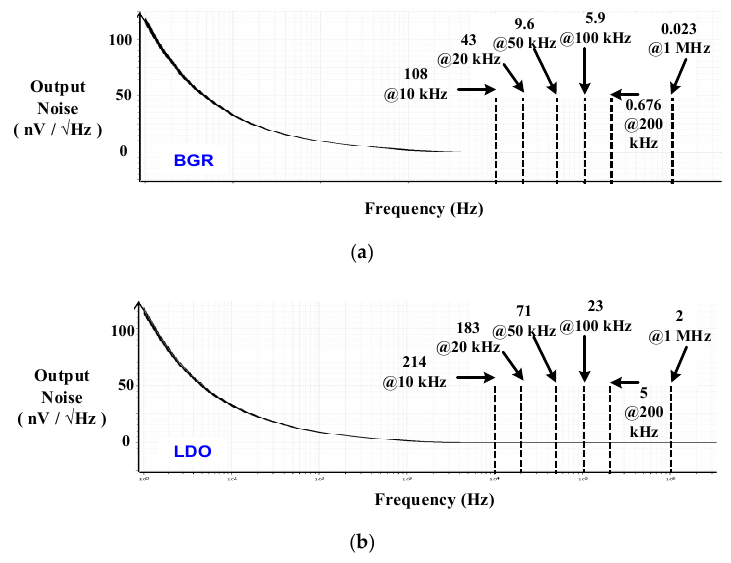
Figure 32. Simulated output noise of ( a ) BGR and ( b ) LDO.